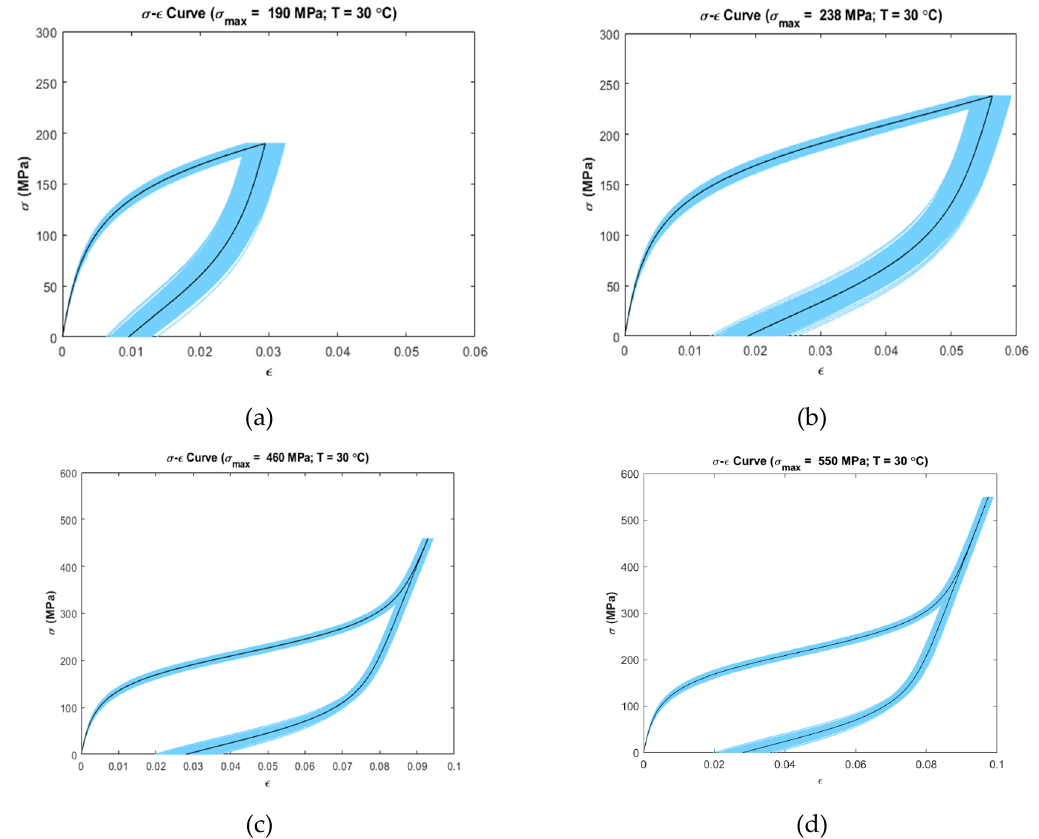
Figure 4. Confidence intervals (5–95 percentile) at simulated temperatures and maximum loading stress (Dark Color shows the deterministic curves); ( a ) T = 30 ◦ C, σ max = 190 MPa ( b ) T = 30 ◦ C, σ max = 238 MPa ( c ) T = 30 ◦ C, σ max = 460 MPa ( d ) T = 30 ◦ C, σ max = 550 MPa.